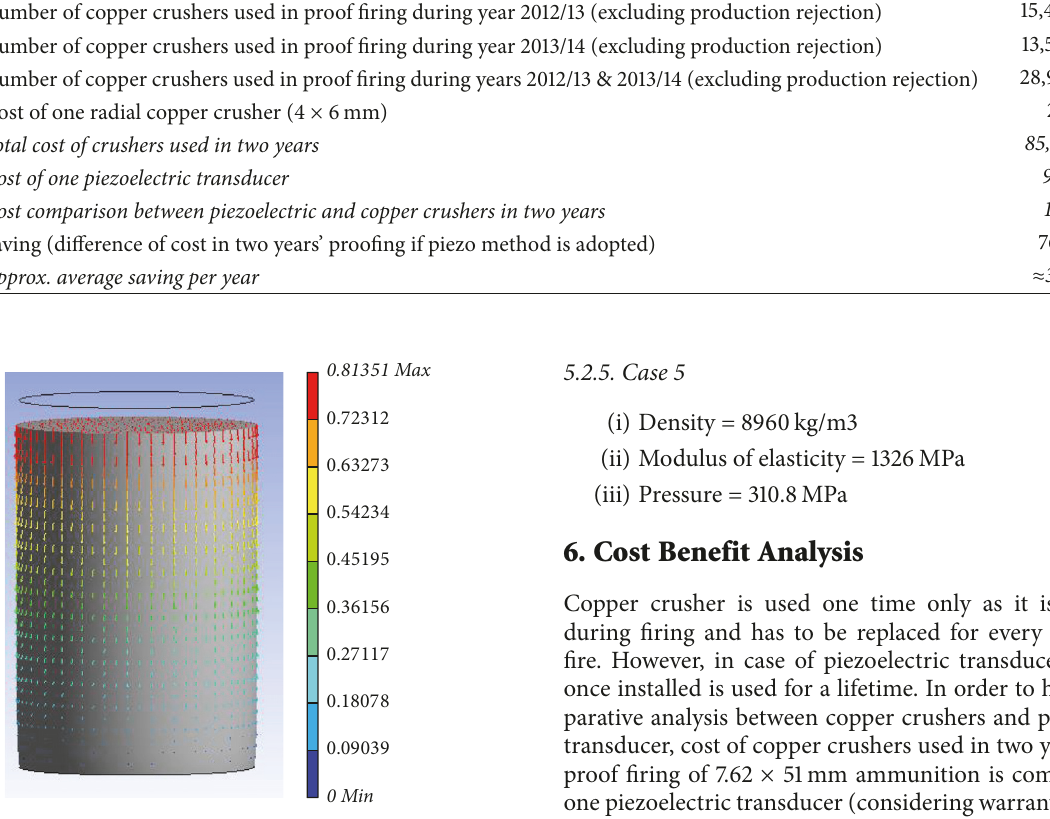
Figure 16: Linear deformation